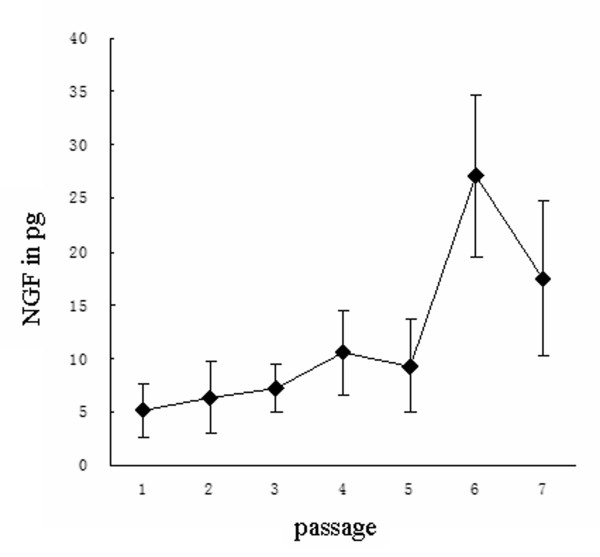
ELISA of nerve growth factor in one-day spent tissue culture media of culture passages five to seven of primary neural stem cells from cortices of E16 Sprague-Dawley rat embryos in three separate experiments. A preponderance of NGF in pg per day of culture of 1 × 106 cells was evident in culture passages six and seven.